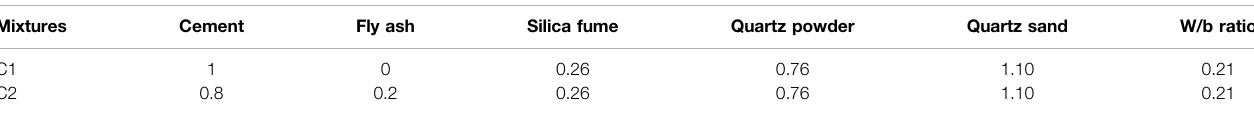
TABLE 2 | Recipes of the mixtures (mass